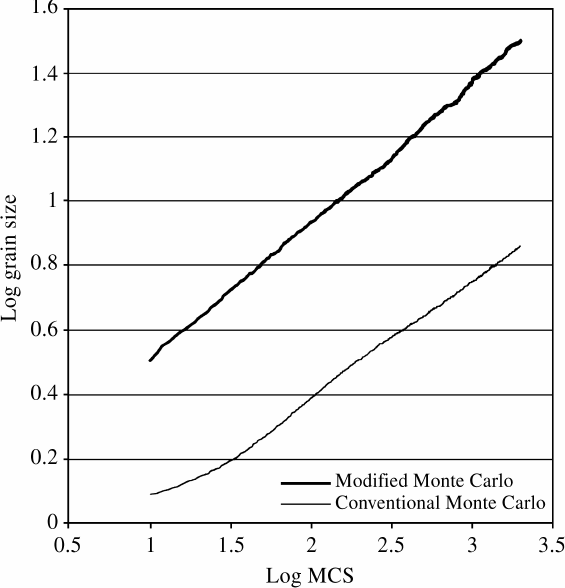
Figure 7. Grain growth behavior with the conventional and modified methods. while n values found for the old method were around 0.35, values of 0.49 were reached for the new